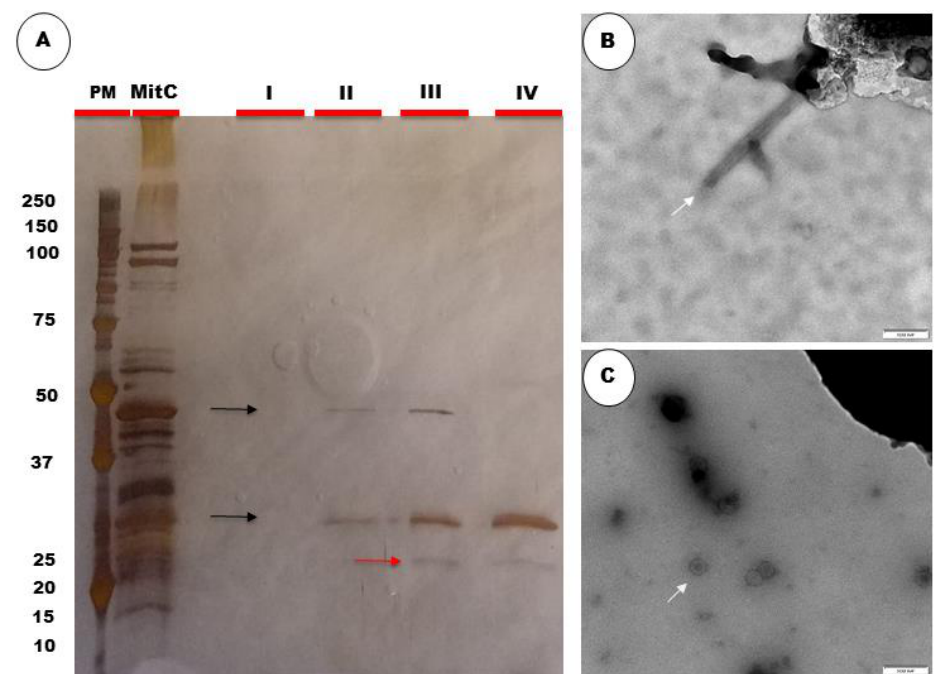
Figure 1. SDS-PAGE and TEM analysis of Bl 1821L putative antibacterial proteins purified using SEC. SDS-PAGE showing purified ~25 (( A ), denoted with red arrow), ~30, and ~48 kD proteins (( A ), denoted with dark arrows) of different pooled fractions. Electron micrographs of Bl 1821L SEC-purified putative antibacterial proteins of pool III ( B ) and pool IV ( C ). The arrows denote a hollow tube-like structure ( B ) and hexagonal or phage capsid-like structures of uniform size ( C ). Scale bar = 100 nm. PM and MitC denote protein marker and mitomycin C, respectively. MitC-induced culture cell-free supernatant was loaded into the MitC